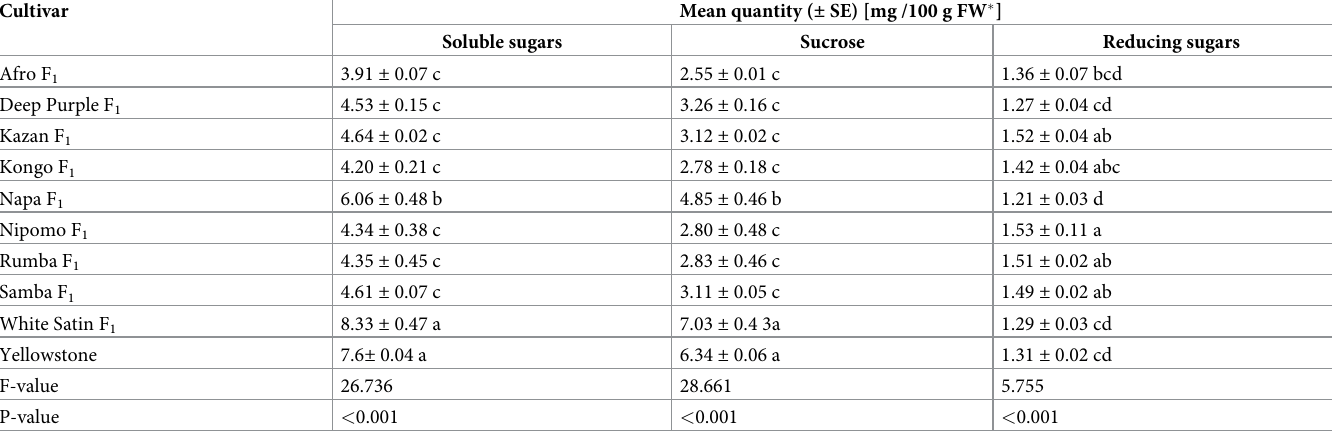
Table 4. The contents of sugars in the leaf petiole and root neck apex of the tested carrot genotypes (one-way ANOVA, factor df = 9, error df = 20). Cultivar